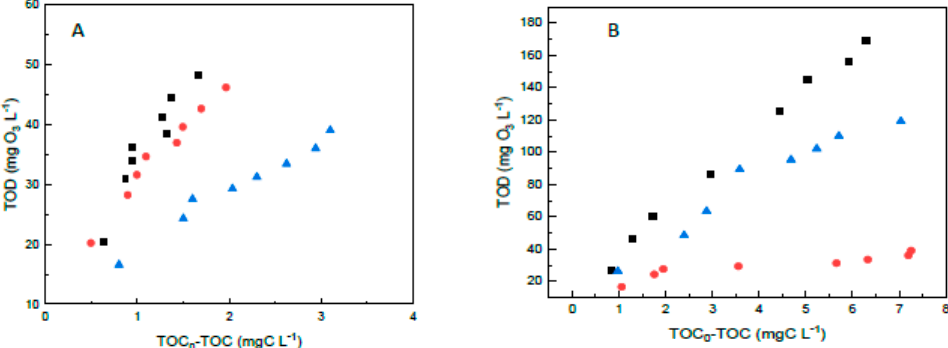
Figure 5. Changes in TOD with eliminated TOC during CatOz ( A ) and PhCatOz ( B ) for TiO 2 ( ), GOTi ( ) and FeGOTi ( ). Conditions: gas flow rate, 35 L h − 1 ; inlet ozone gas concentration, 10 mg L − 1 ; primidone, C 0 = 10 mg L − 1 ; TOC 0 = 6.6. mgL − 1 ; catalyst dosage, 0.25 g L − 1 ; agitation speed, 700 rpm.